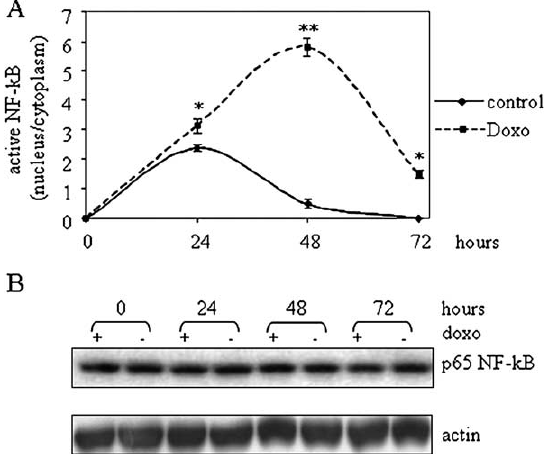
Fig. 4. Doxorubicin induces NF- κ B nuclear translocation in MCF7 cells. (A) Native MCF7 cells were starved overnight and treated for up to 72 h with 50 nM Doxo in the presence of 10% FBS. NF- κ B/p65 content was then evaluated in cytoplasmic and nuclear proteins by ELISA. Results are expressed as the ratio between nuclear and cyto- plasmic NF- κ B immunoreactivity in control untreated native MCF7 cells (control) and in native MCF7 cells treated with 50 nM Doxo (Doxo). * p < 0 . 05 and ** p < 0 . 01 vs. control untreated na- tive MCF7 cells. (B) Native MCF7 cells were starved overnight and treated for up to 72 h with 50 nM Doxo in the presence of 10% FBS. NF- κ B/p65 total cellular content was then evaluated by West- ern blot. Upper panel: total cellular NF- κ B protein levels in native MCF7 cells treated without ( − ) and with 50 nM Doxo ( + ). Lower panel: total actin protein in native MCF7 cells treated without ( − ) and with 50 nM Doxo ( +